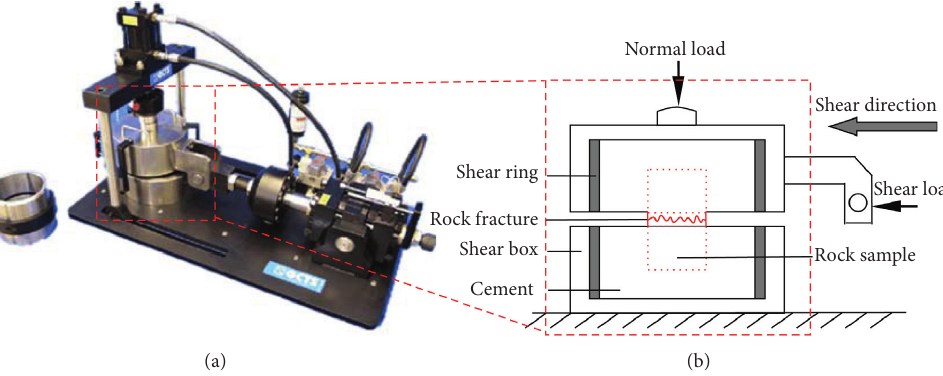
Figure 1: (a) RDS-200 rock mechanics shear test system. (b) Simplified diagram of the testing system [26].